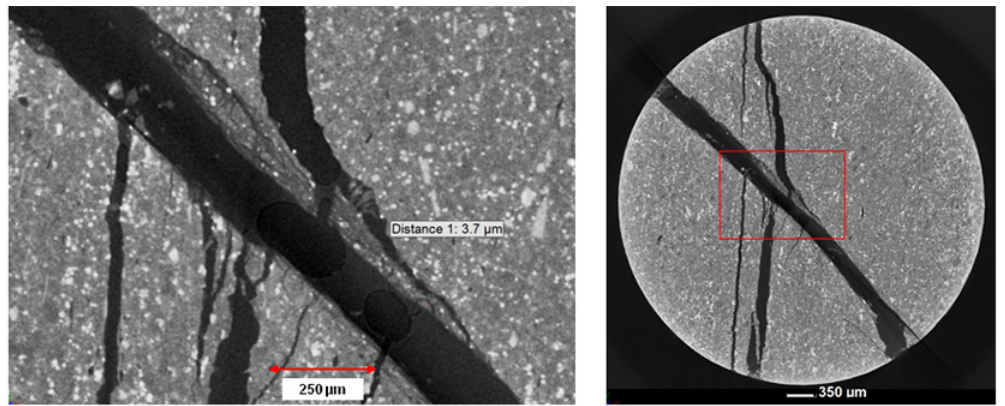
Figure 9. For the high-resolution dataset, many small cracking features can be observed. The magnified area marked by the red box is of special interest, since indications for a mylonitic zone can be found where the disking and shear fracture intersect.